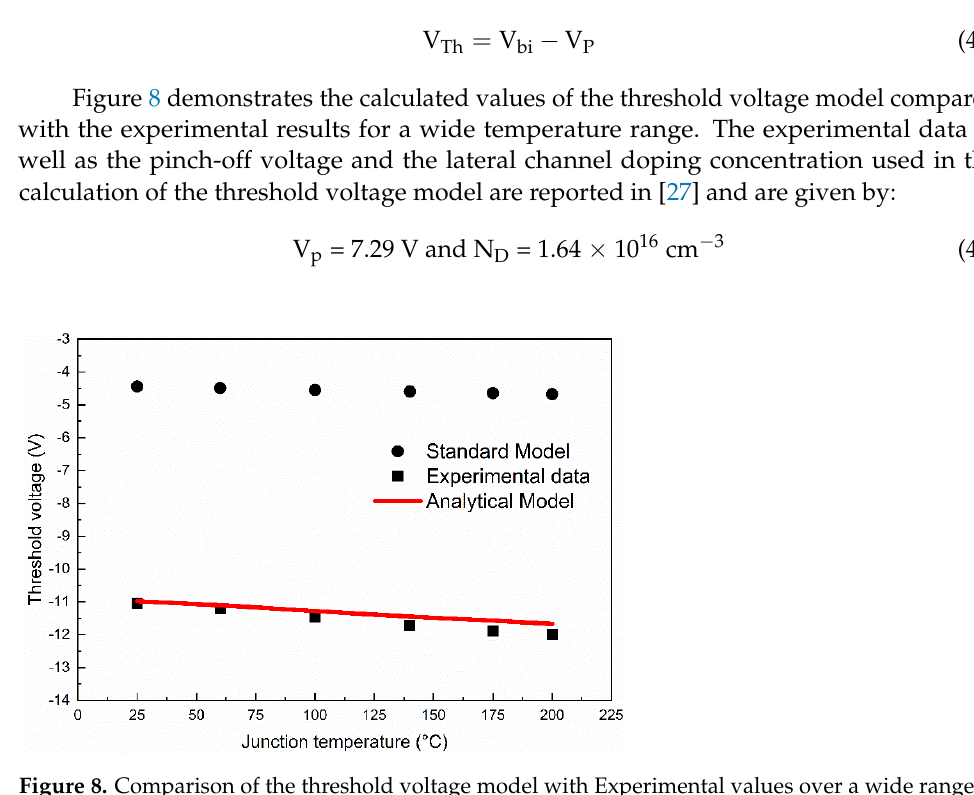
Figure 7. Comparison of Analytical and Numerical solutions of 0 ( )   function.